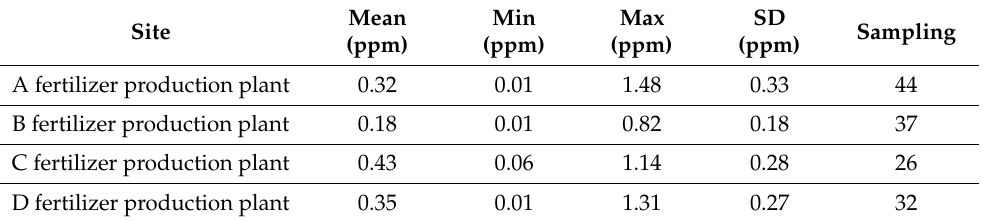
Table 2. NH 3 concentration of the investigated NPK fertilizer production plants.